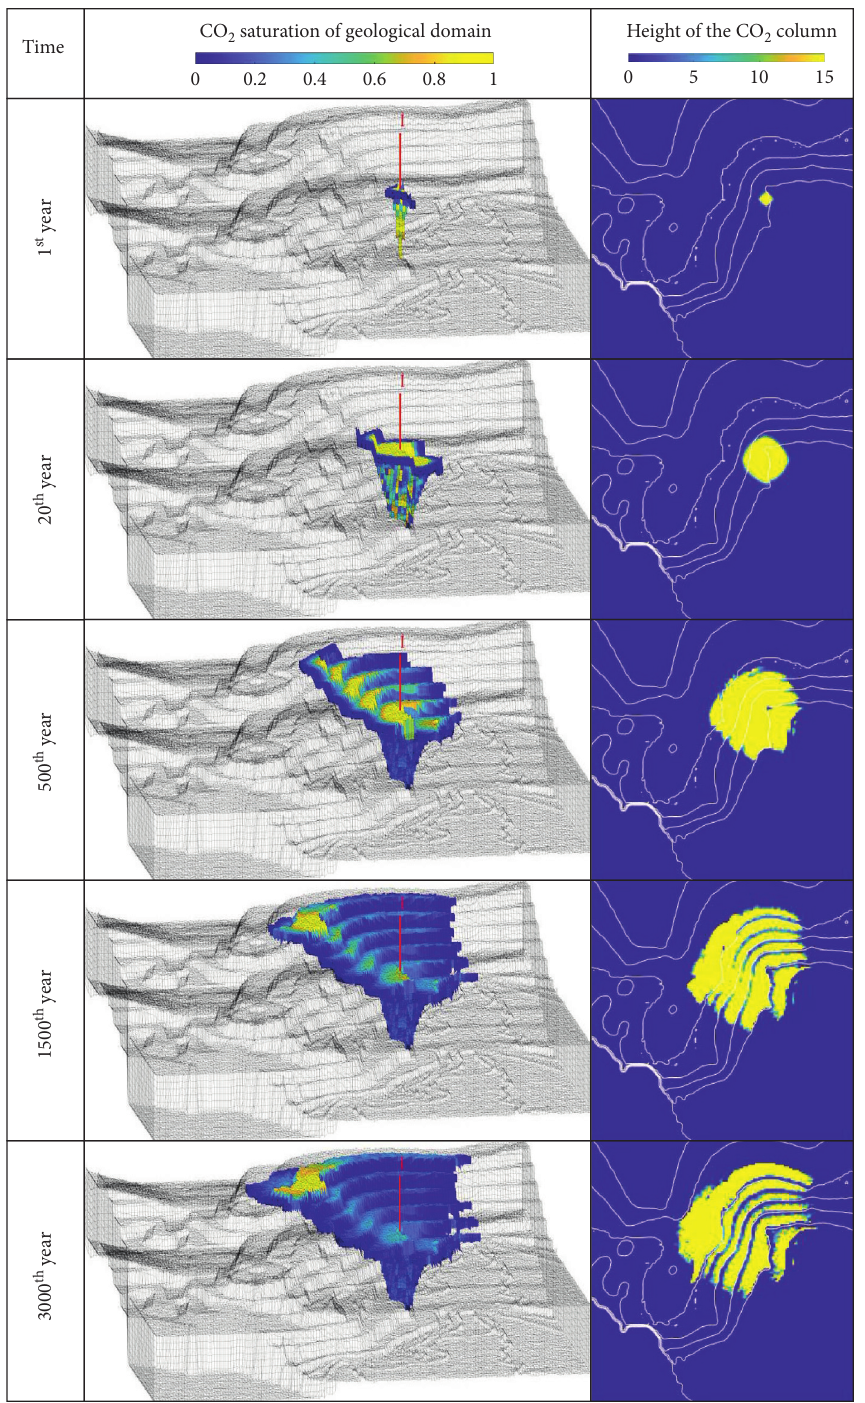
Figure 3: The fate of CO 2 during the structural and residual trapping phenomena over geological time represented in the form of (i) height of the saturated CO 2 from the surface; (ii) CO 2 saturation in the 3D domain. Total 7.227 × 10 10 m 3 of CO 2 injected for initial 20